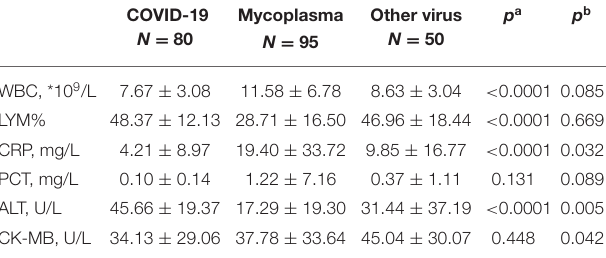
TABLE 2 | Laboratory features of pediatric patients.